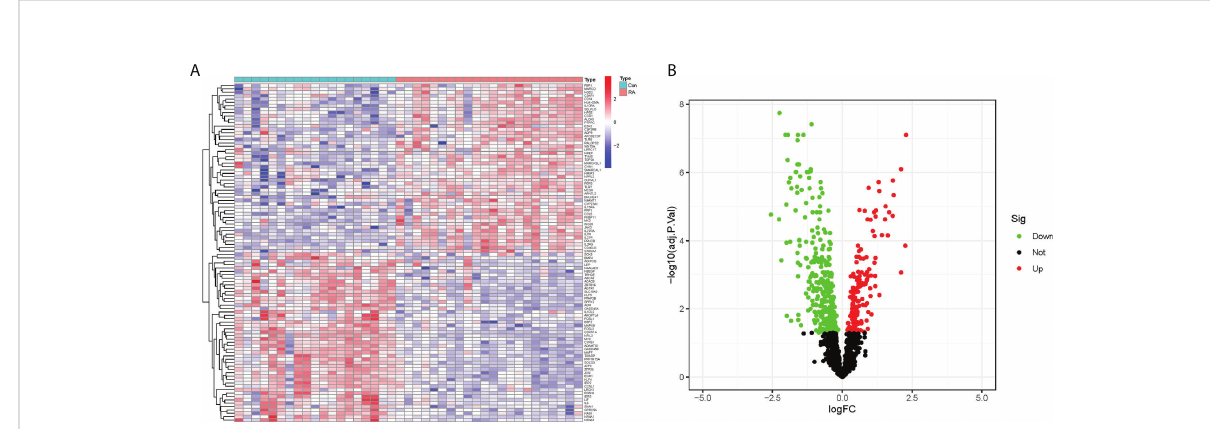
FIGURE 2 Identi fi cation of DECRGs between RA and control groups. (A) Heatmap of expression differences of CRGs (Green: low expression level; Red: high expression level). (B) Volcano plot of DECRGs (Green: down-regulated genes; Red: up-regulated